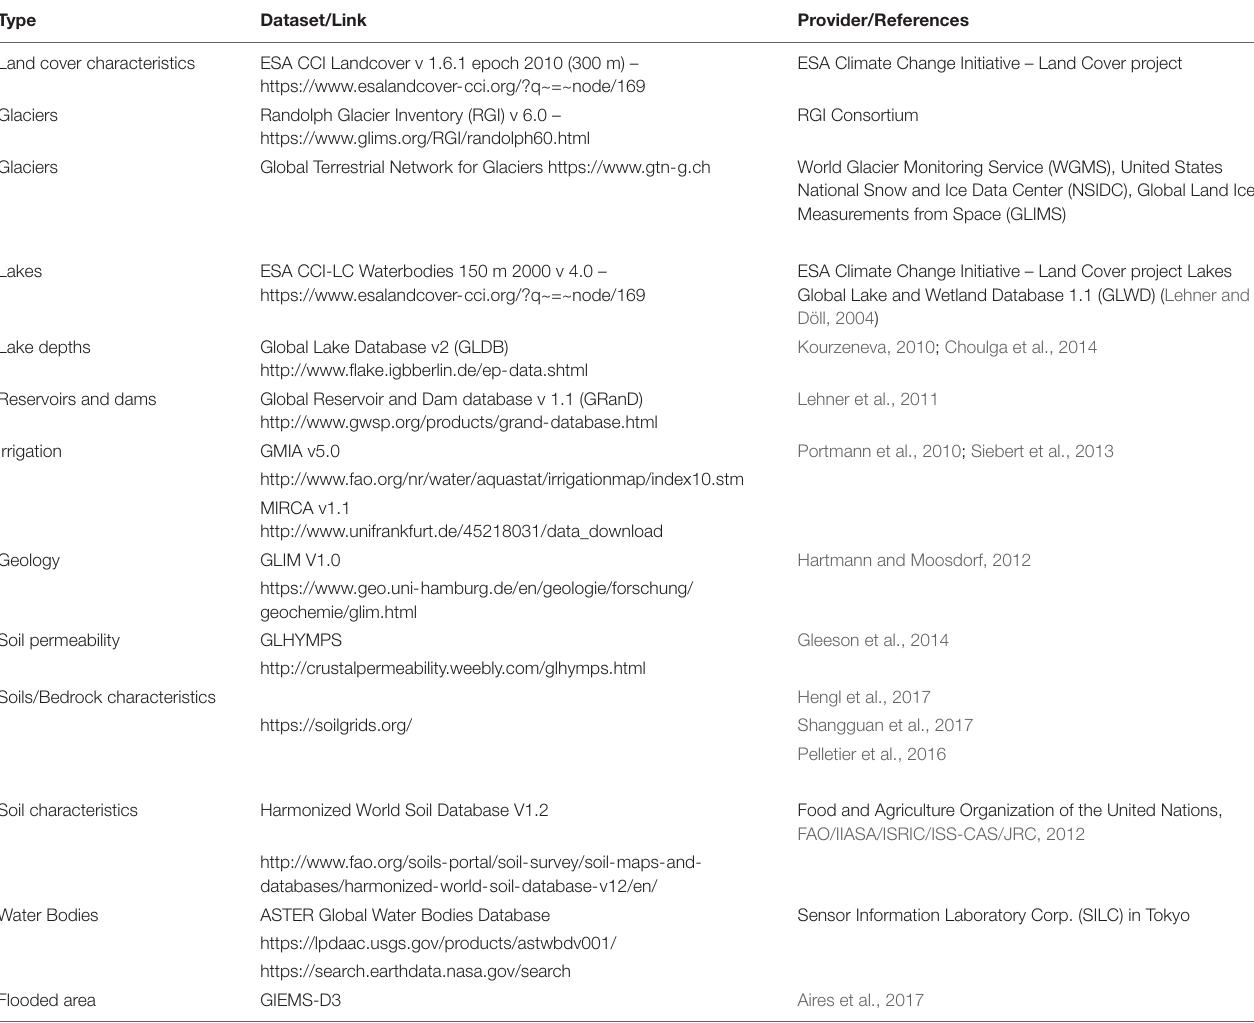
TABLE 6 | Datasets available for the physiographic data